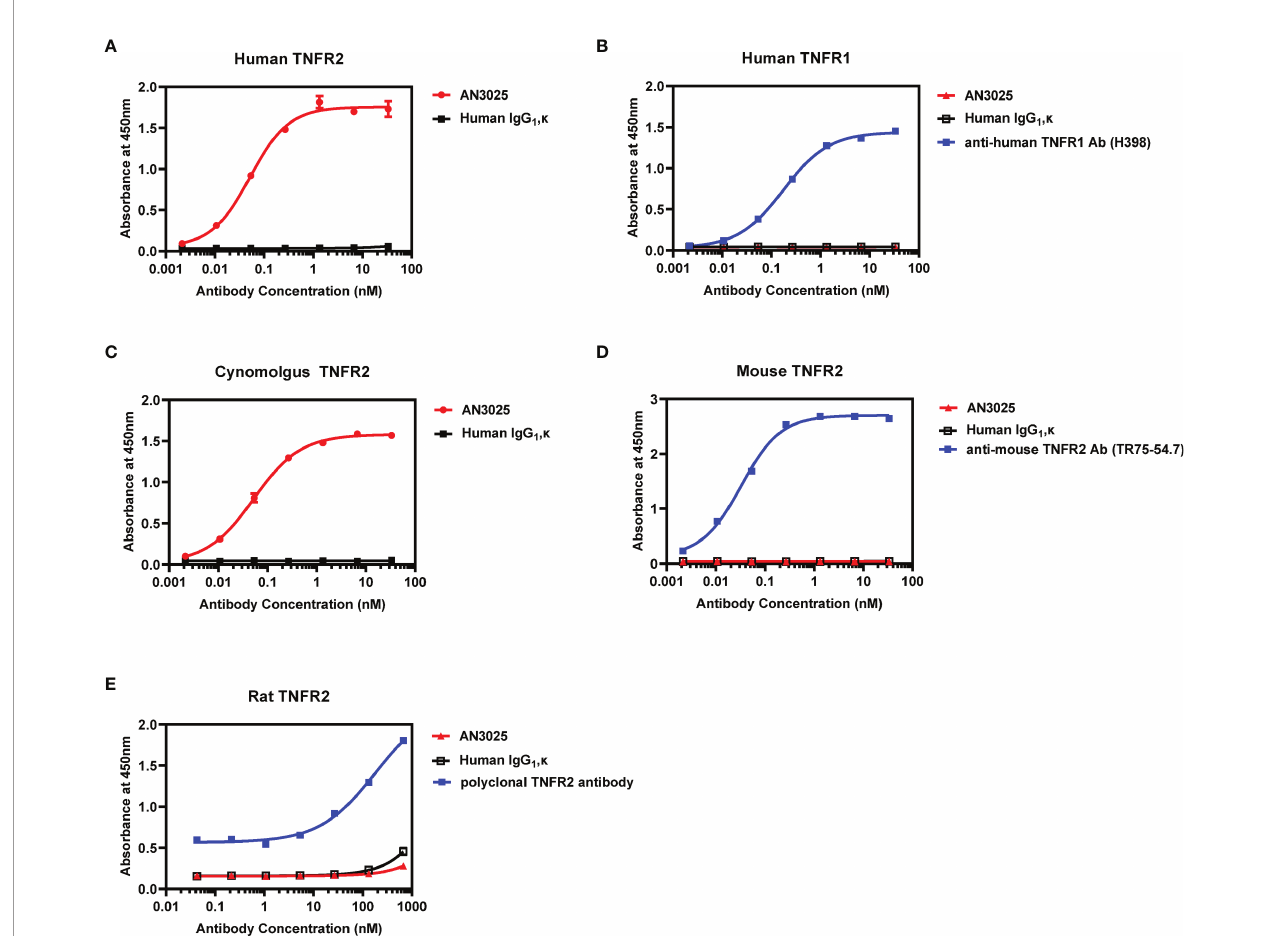
FIGURE 1 | AN3025 binds to human TNFR2 and cynomolgus TNFR2 selectively. (A) Binding assay of AN3025 to human TNFR2 on plate by ELISA (EC 50 = 0.052nM). (B) Binding assay of AN3025 to human TNFR1 on plate by ELISA. (C) Binding assay of AN3025 to cynomolgus TNFR2 on plate by ELISA (EC 50 = 0.053nM). (D) Binding assay of AN3025 to mouse TNFR2 on plate by ELISA. (E) Binding assay of AN3025 to rat TNFR2 on plate by ELISA. The ELISA assays were tested in duplicates. Values were expressed as Mean ±